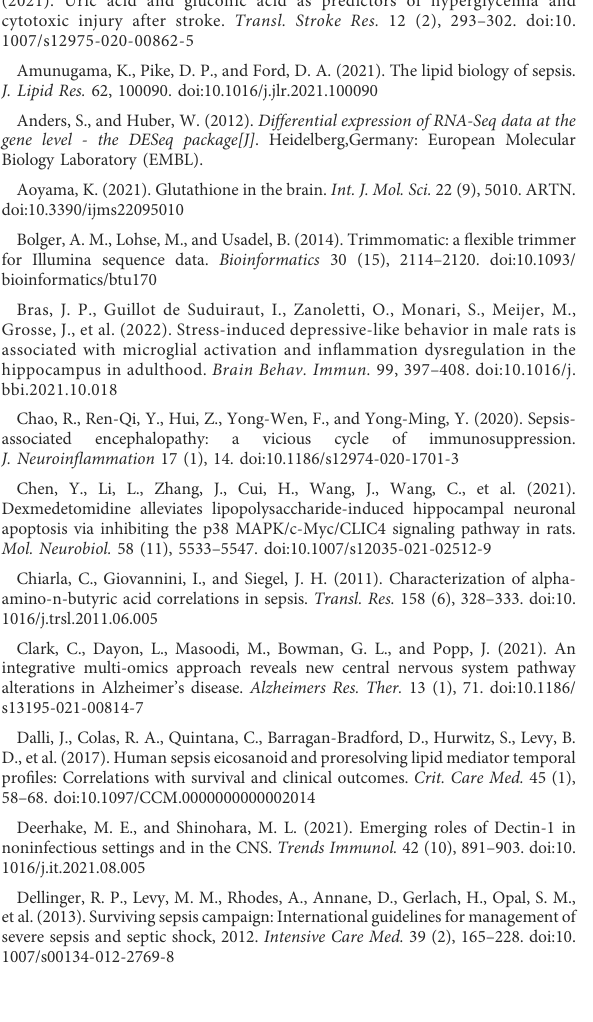
SUPPLEMENTARY FIGURE S1 Heatmap analysis of in fl ammation-related pathways and cell death. SUPPLEMENTARY FIGURE S2 Heatmap analysis of the metabolism of the lipids, amino acids and nucleotides, and synapse. SUPPLEMENTARY TABLE S1 List of differentially expressed genes. SUPPLEMENTARY TABLE S2 GSEA analysis of biological events in the hippocampus of